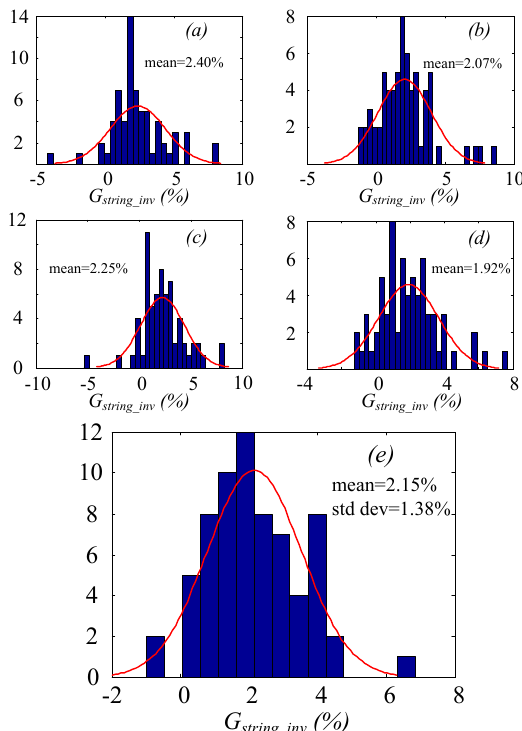
Figure 16. G string_inv distribution charts and normal density fitting functions for the case study: ( a ) QPCA 1 vs. central inverter 1, ( b ) QPCA 1 vs. central inverter 2, ( c ) QPCA 2 vs. central inverter 1, ( d ) QPCA 2 vs. central inverter 2, ( e ) string inverters subfield (QPCA 1 + QPCA 2) vs. central inverters subfield (central 1 + central 2). The integrated state-space average model presented in this paper is used to replace data recorded by the monitoring system of the real PV plant in case of data issues, unavailability or external constraints.